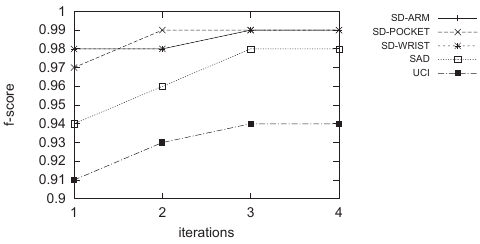
Figure 11: Percentage of weak learners that are trained on magnetometer features during the adap- tation process.